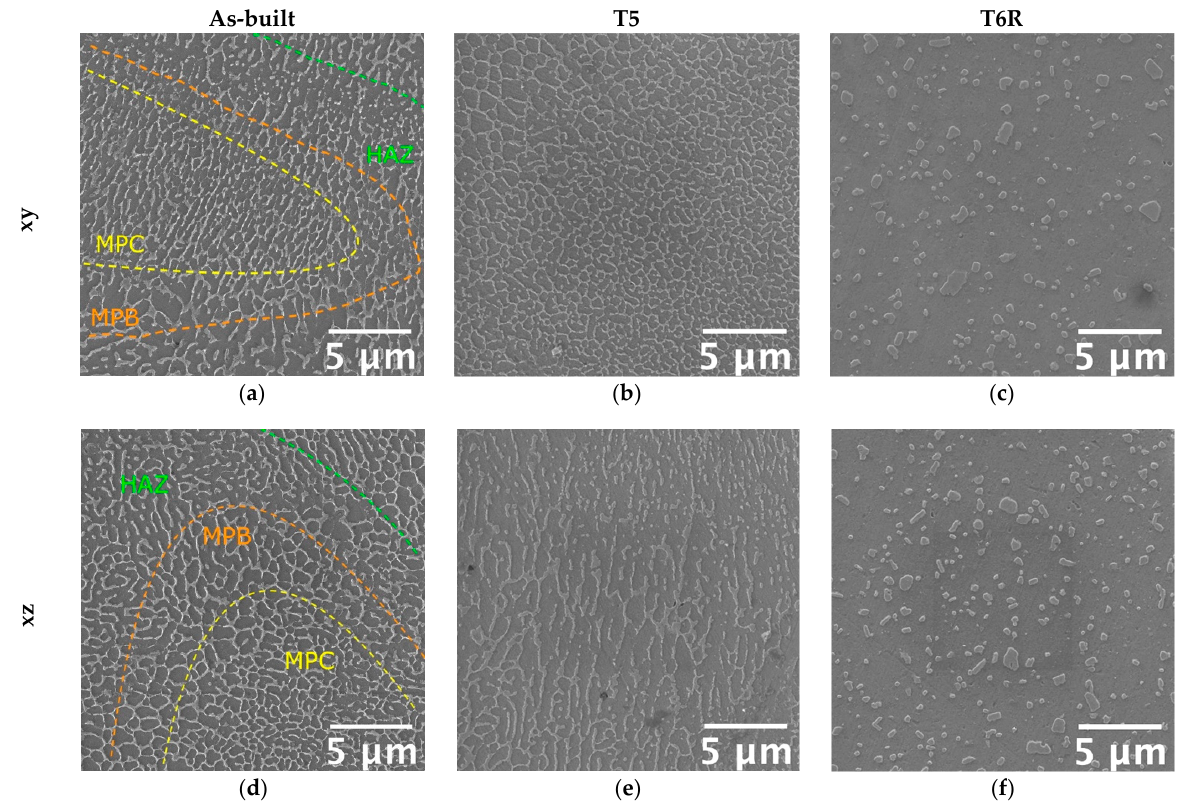
Figure 7. FEG-SEM high magnification micrographs showing the typical microstructure of the as- built, T5, and T6R AlSi7Mg PBF-LB alloy: ( a – c ) along the direction parallel to the building platform (xy plane); ( d – f ) along the direction parallel to the building one (xz plane).